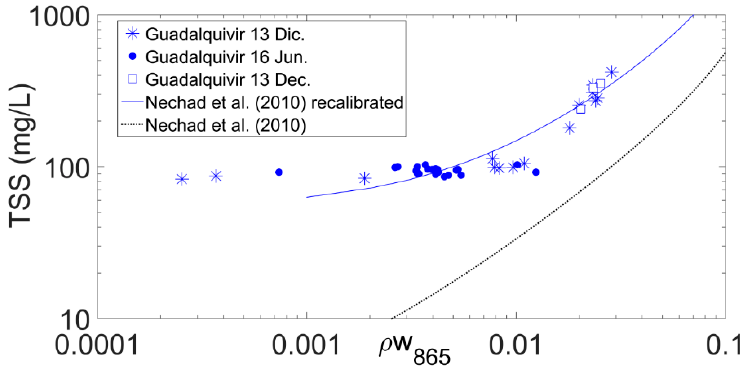
Figure 5. Relationship for Total Suspended Solids (TSS) retrieval in the Guadalquivir estuary based on the recalibrated reflectance model [29] using the near-infrared (NIR) band at 865 nm (blue line, logarithmic scales). Black dashed line represents the original fit at this wavelength.